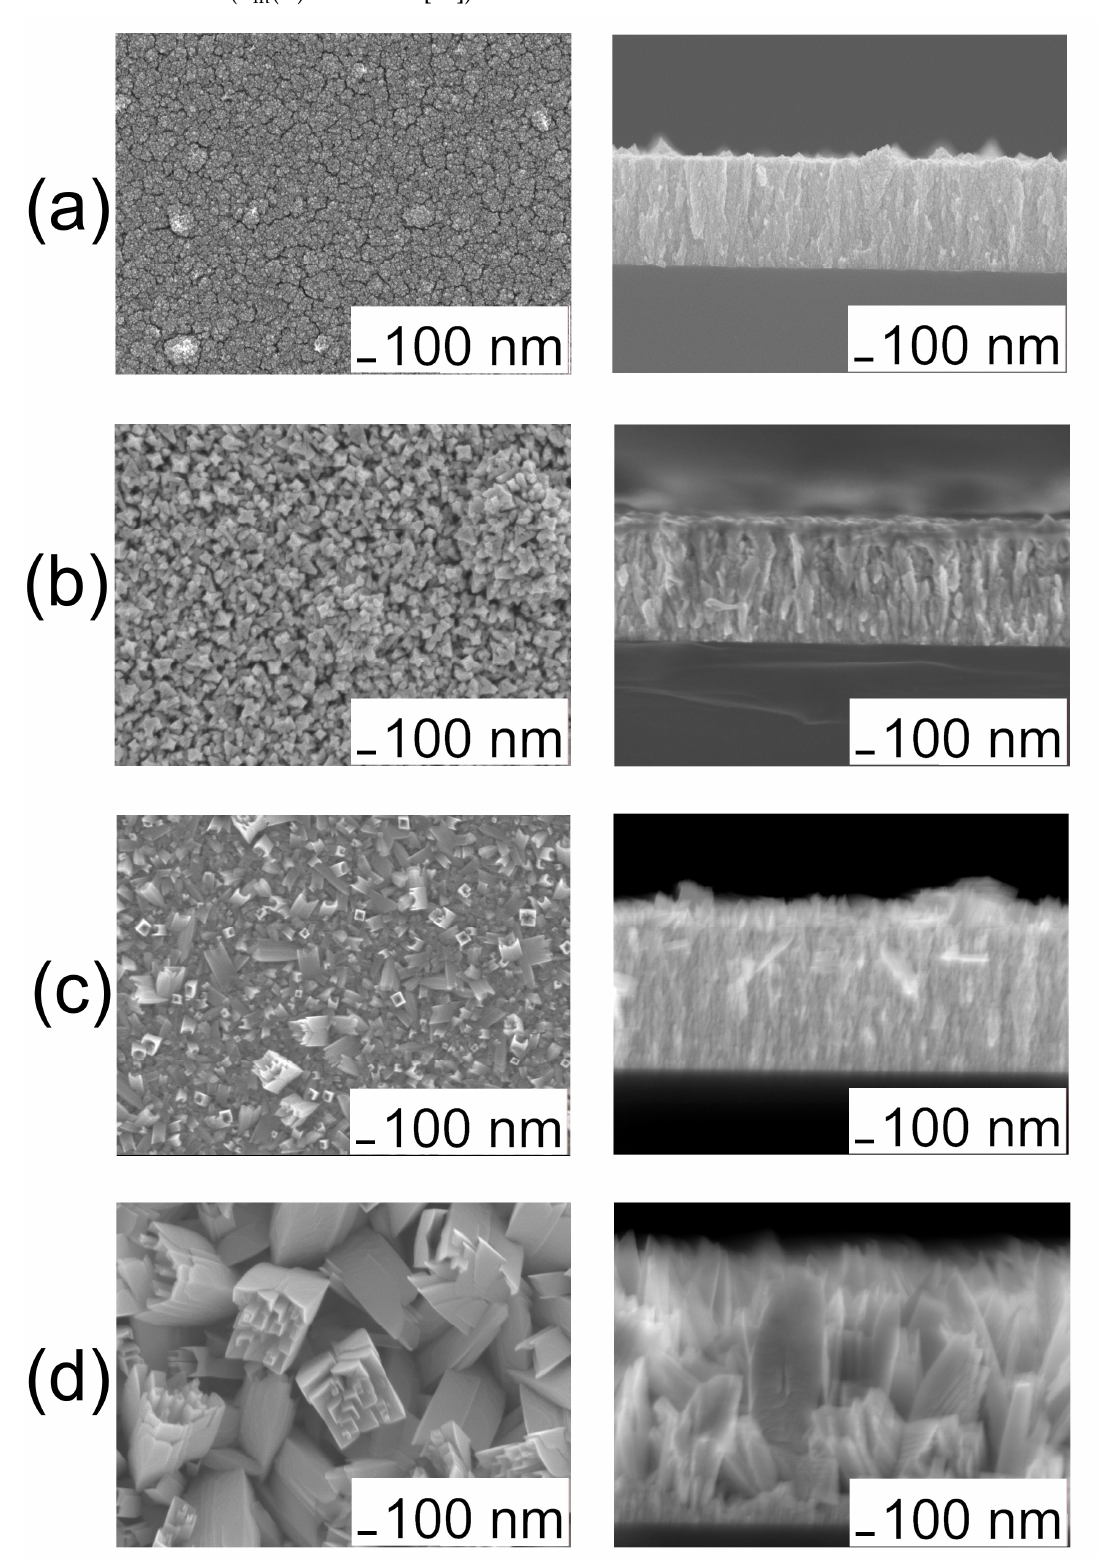
Figure 1. SEM micrographs of the surface (on left) and cross-section (on right) of iridium coatings on Si(100), samples 1 ( a ), Figure 1 3 ( b ), 4 ( c ), 5 ( d ); magnification 50,000